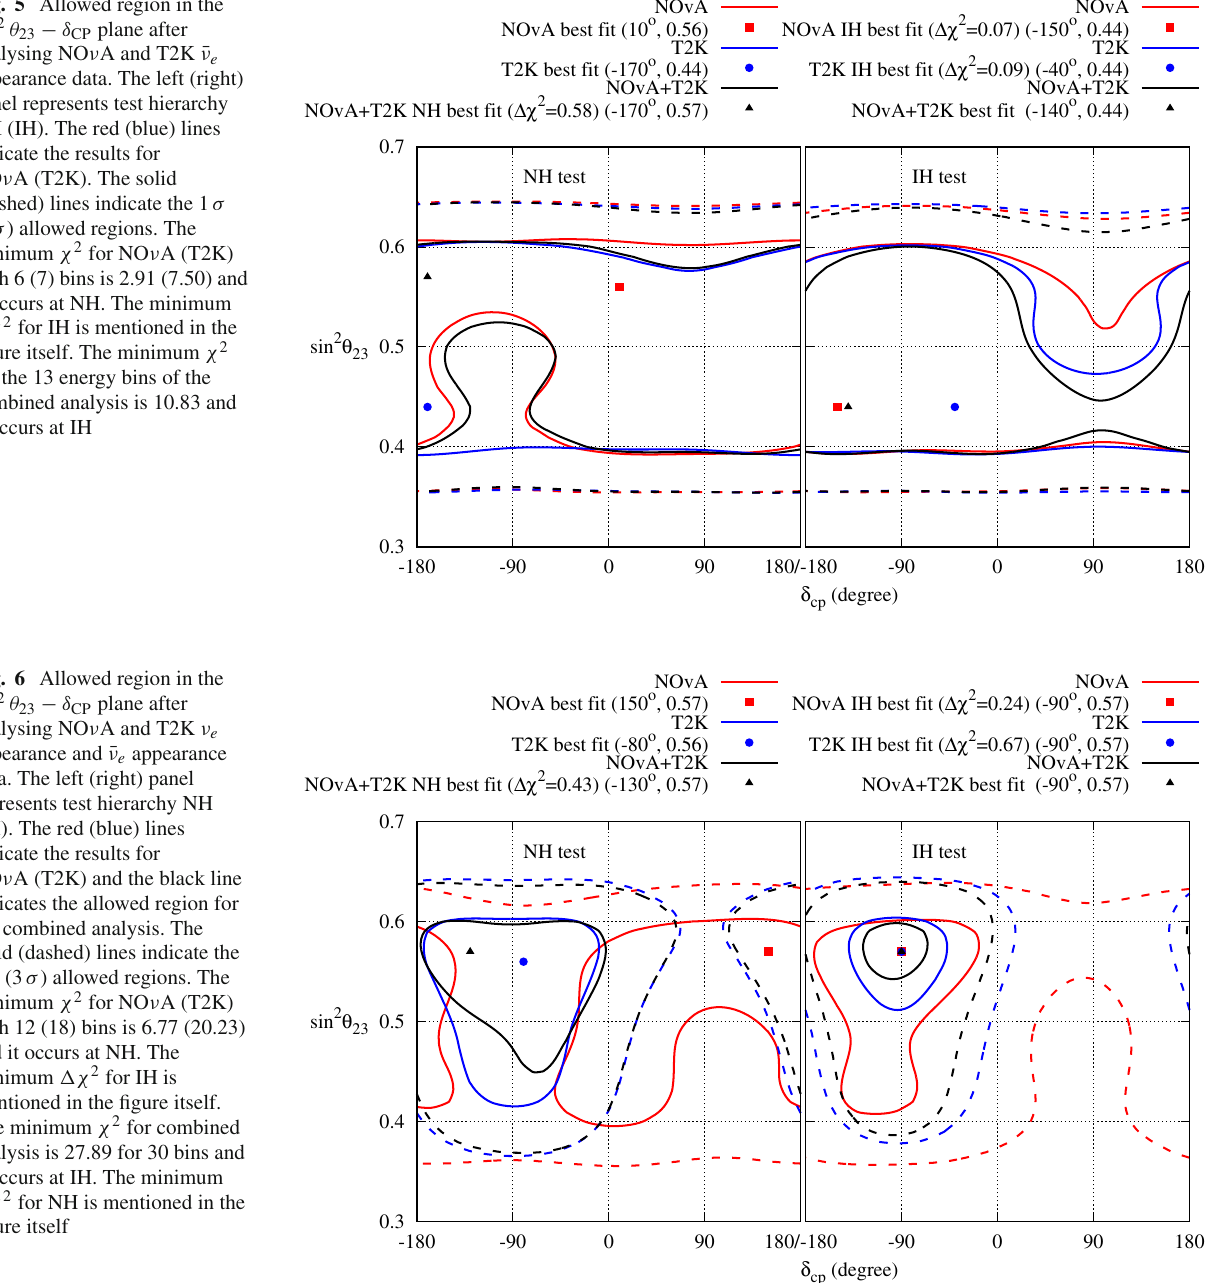
Fig. 5 Allowed region in the sin 2 θ 23 − δ CP plane after analysing NO ν A and T2K ¯ ν e appearance data. The left (right) panel represents test hierarchy NH (IH). The red (blue) lines indicate the results for NO ν A (T2K). The solid (dashed) lines indicate the 1 σ (3 σ ) allowed regions. The minimum χ 2 for NO ν A (T2K) with 6 (7) bins is 2.91 (7.50) and it occurs at NH. The minimum (cid:5)χ 2 for IH is mentioned in the figure itself. The minimum χ 2 for the 13 energy bins of the combined analysis is 10.83 and it occurs at IH